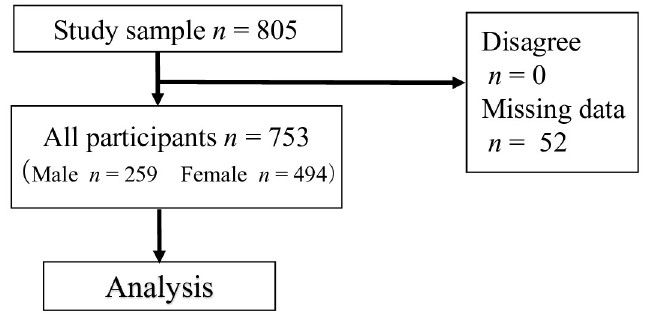
Fig 1. Flowchart of sampling of